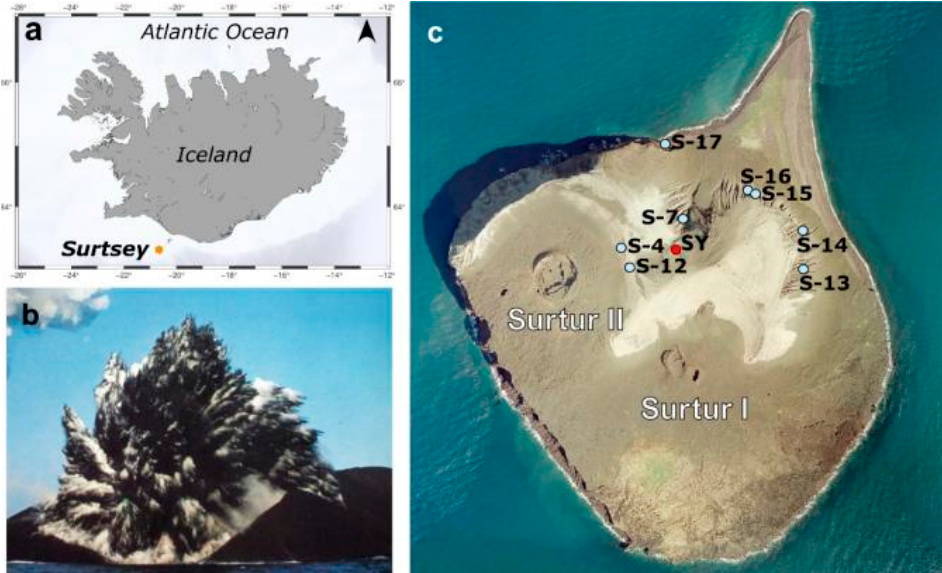
Figure 1. Location: ( a ) position of the island of Surtsey, SSW of Iceland’s mainland in the North Atlantic; ( b ) Surtsey in eruption (photo by Sverrir Einarsson); ( c ) orthophoto of Surtsey, taken in 2012 (courtesy of Loftmyndir ehf), with sample locations provided for the two sample sets collected on the island in 2014 (S samples, light blue dots) and 1991 (SY samples, red dot).